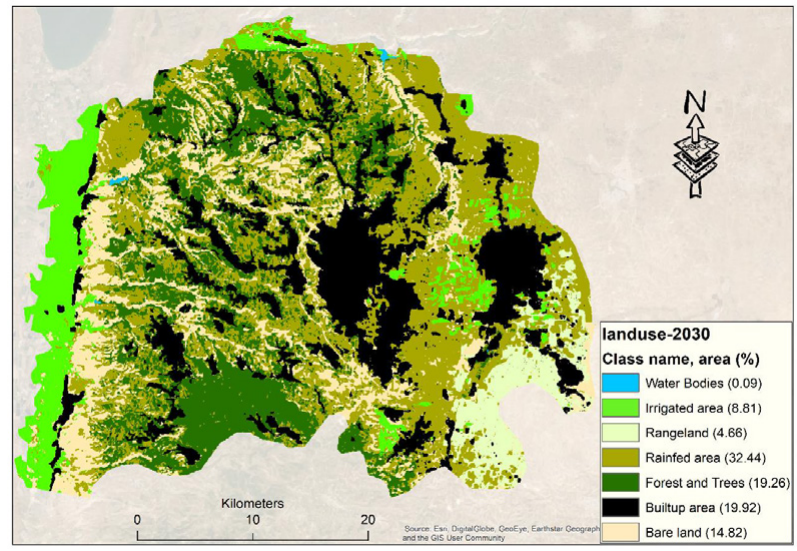
Fig. 4a: Predicted LULC changes in Irbid governorate for 2030